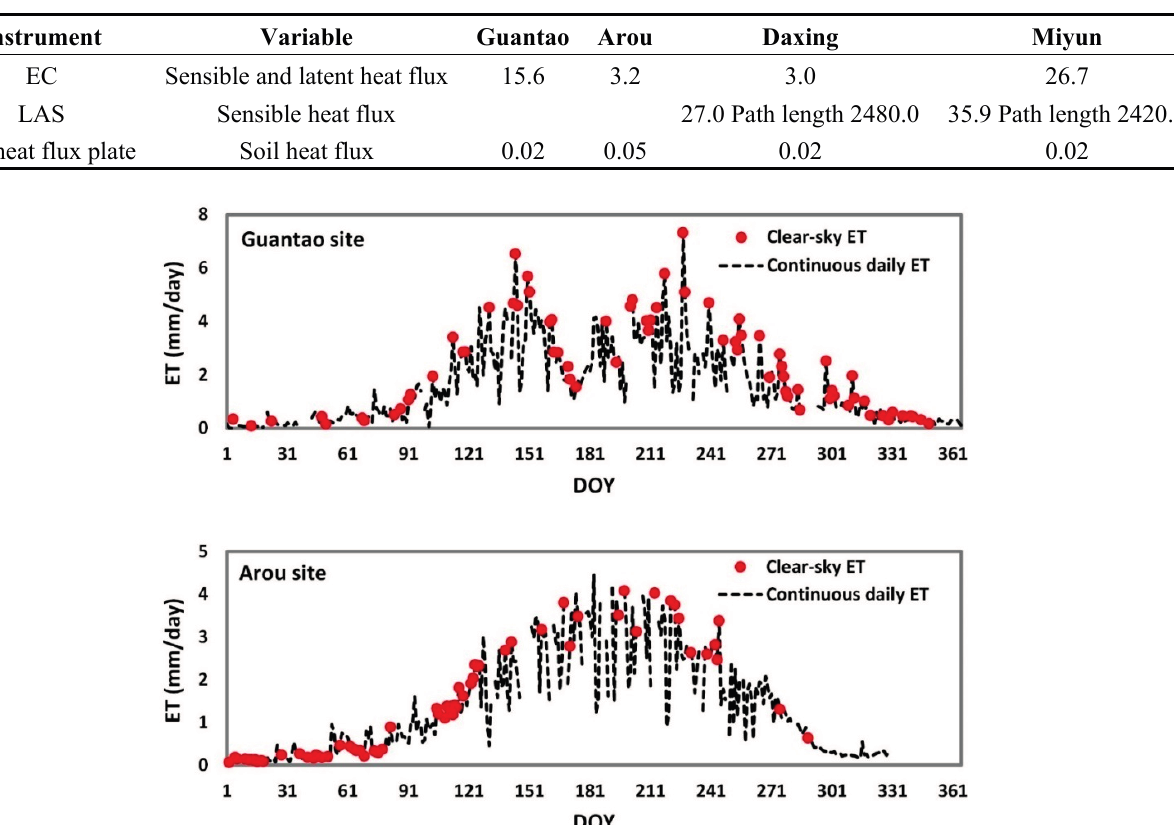
Table 3. Summary of surface heat flux measurement height/depth (m).